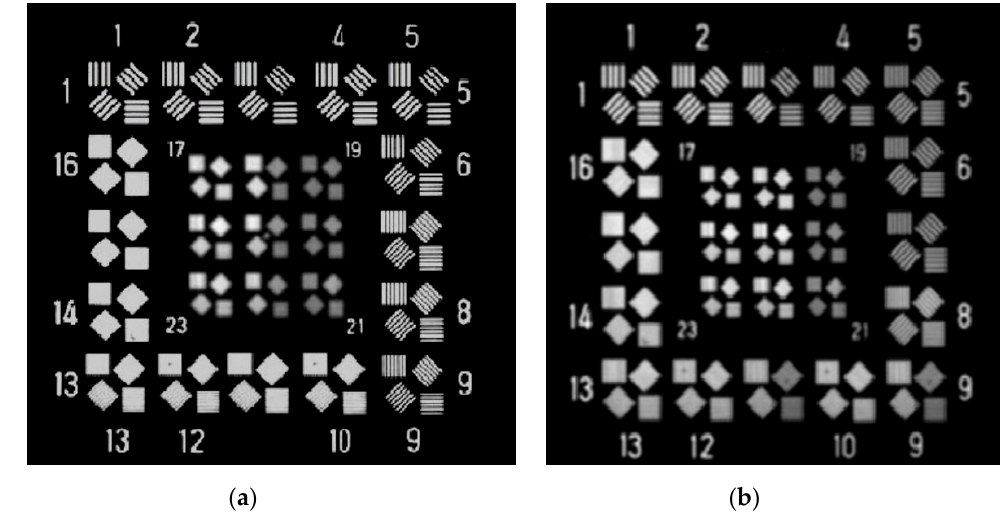
Figure 10. Images obtained at different temperatures: ( a ) at the initial temperature; ( b ) at low temperatures after 1 h.